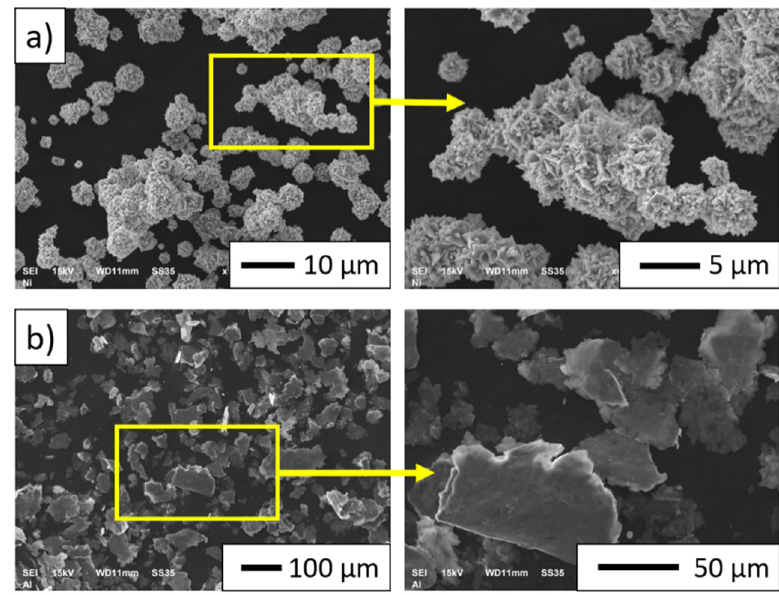
Figure 2. Morphology of metallic powders: ( a ) nickel; ( b )